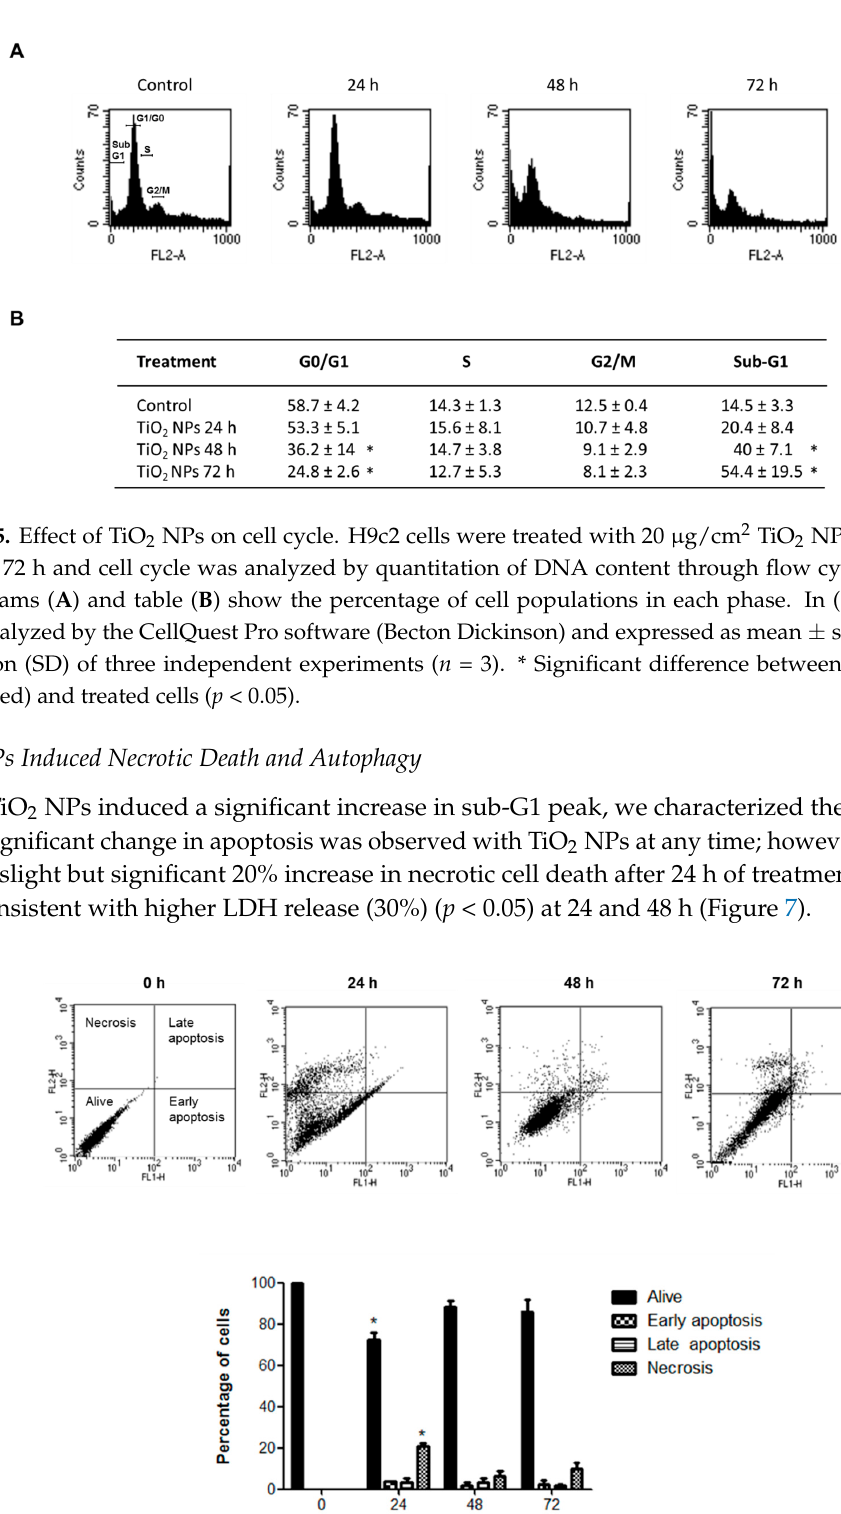
Figure 6. TiO 2 NPs induced necrotic death. H9c2 cells were treated with 20 μ g/cm 2 TiO 2 NPs for 24, 48, and 72 h, then apoptotic and necrotic death was measured by annexin ‐ V and propidium iodide staining. Dot blots show resolution of live, apoptotic and necrotic populations ( A ) and the bar chart show the percentages ( B ) as mean ± standard deviation (SD) of three independent experiments ( n = 3). * Significant difference between control (untreated) and treated cells ( p < 0.05).